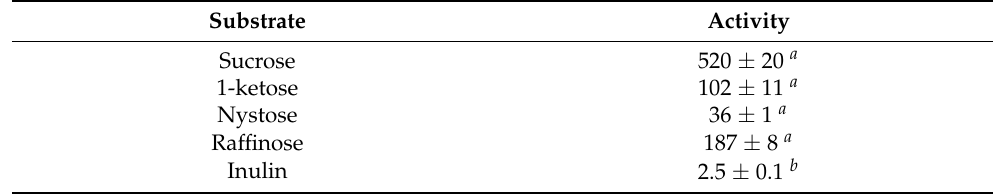
Table 4. Specific activity (in U/mg units) of S INV. Table from reference [97]. Substrate